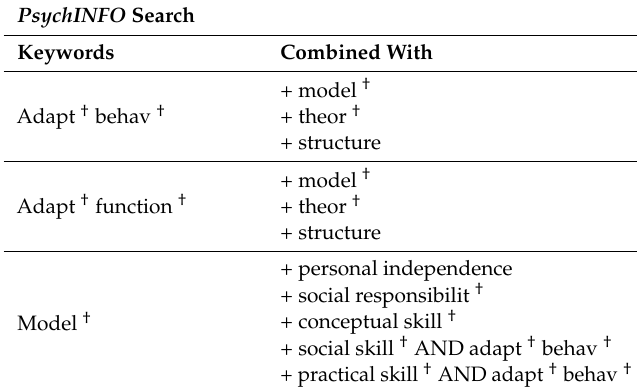
Table 1. Syntax used in the systematic literature search for PsychINFO.